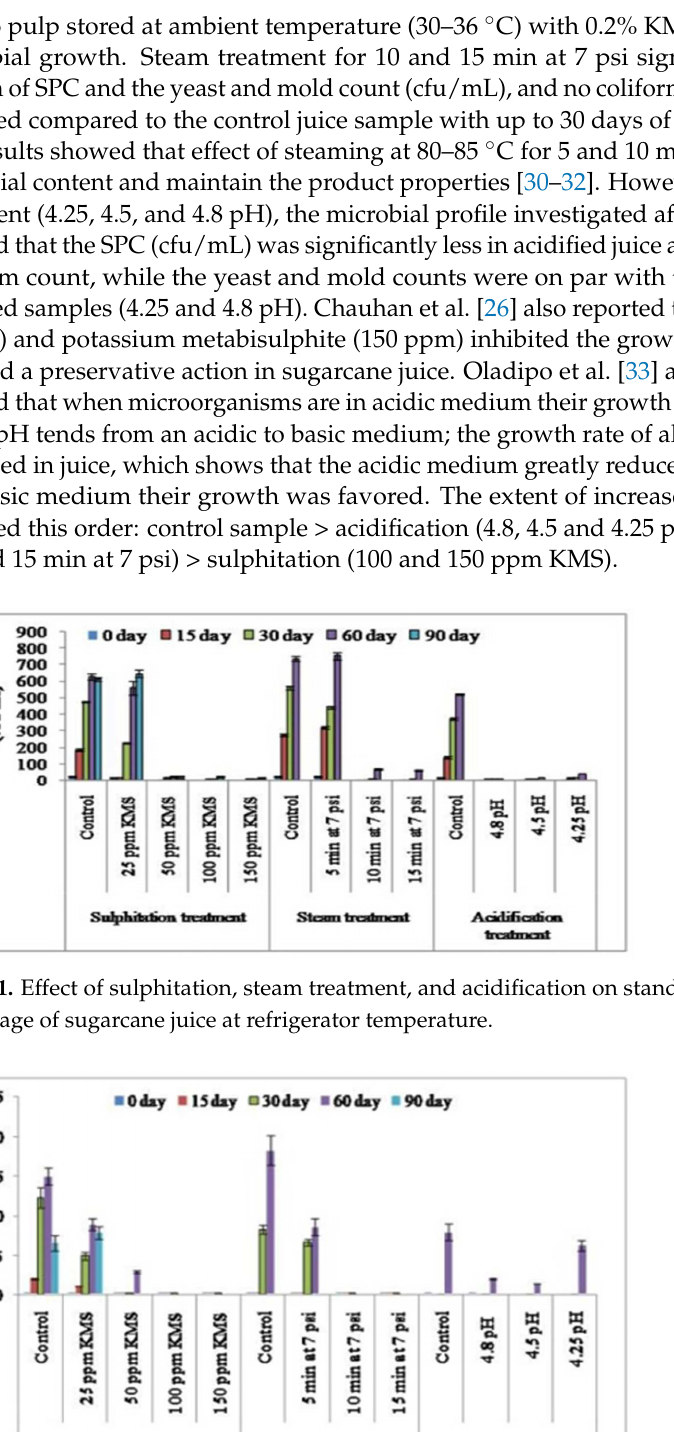
Figure 2. Effect of sulphitation, steam treatment, and acidification on thecoliform countduring stor- age of sugarcane juice at refrigerator temperature.